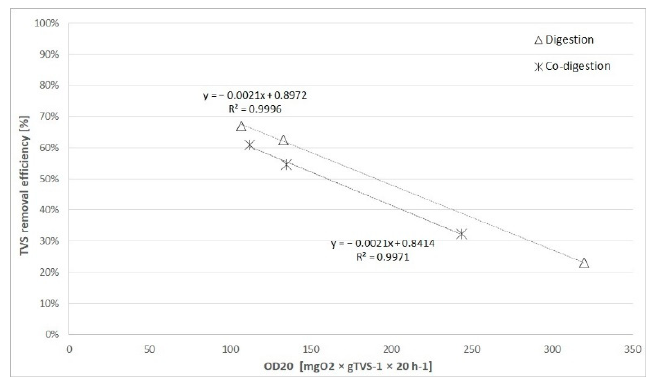
Figure 4. Correlation between OD 20 and TVS removal efficiency for the digestion and co-digestion process.